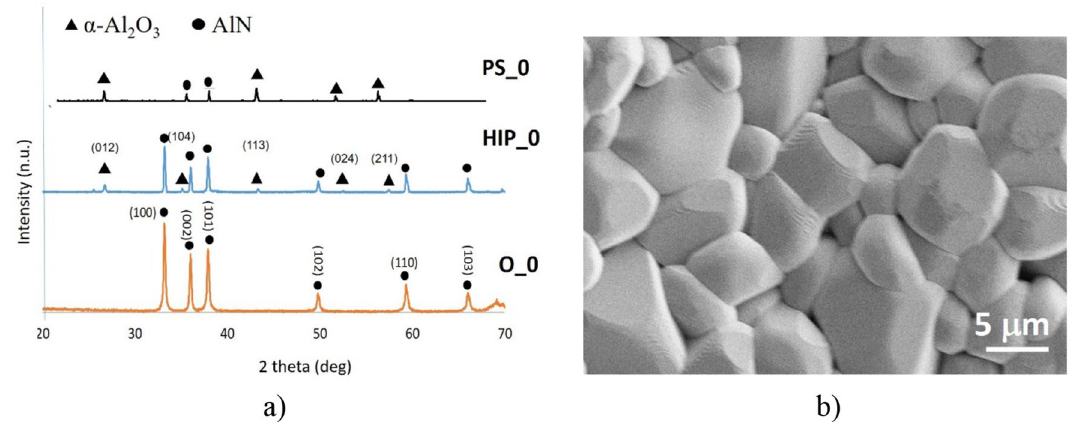
Figure 4. Investigation of AlN reference. ( a ) XRD plots of reference AlN powder (O_0), HIP sintered (HIP_0) and sintered at H 2 (PS_0), ( b ) SEM image of